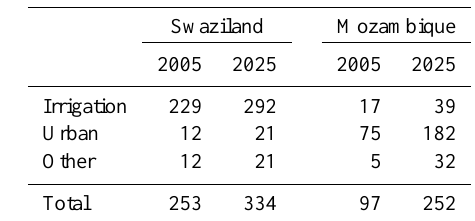
Table 1. Water demands in Umbeluzi River (MCM/yr). Source: SWECO and Associates